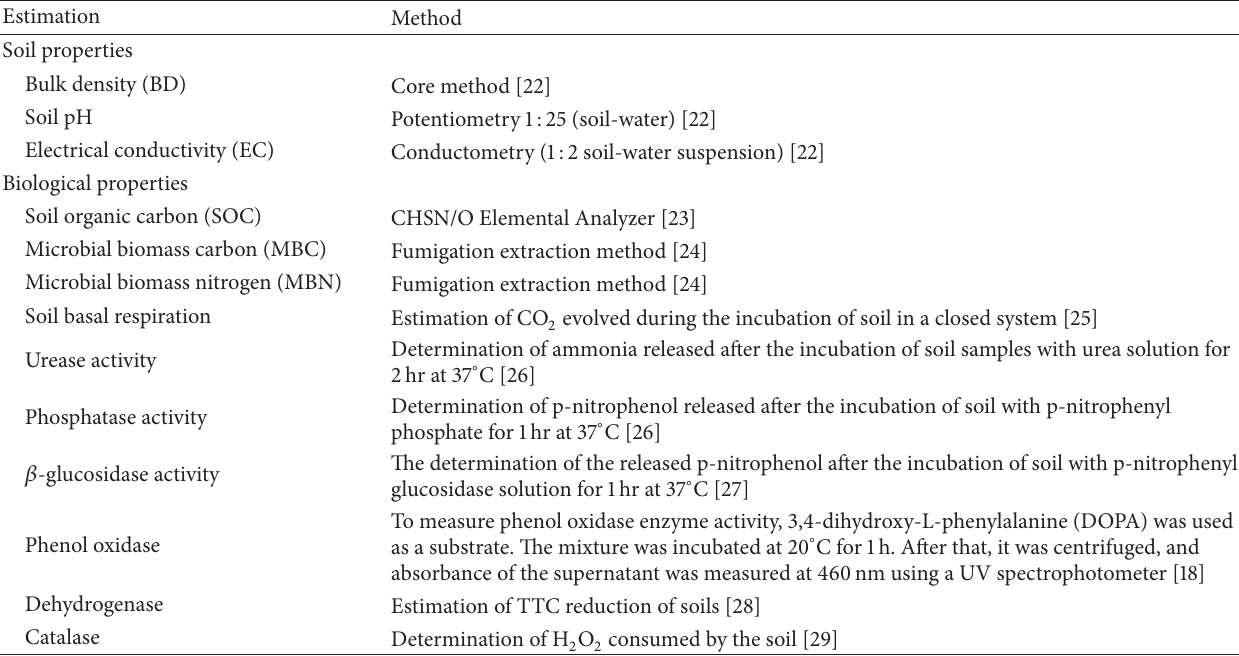
Table 1: Methods for soil